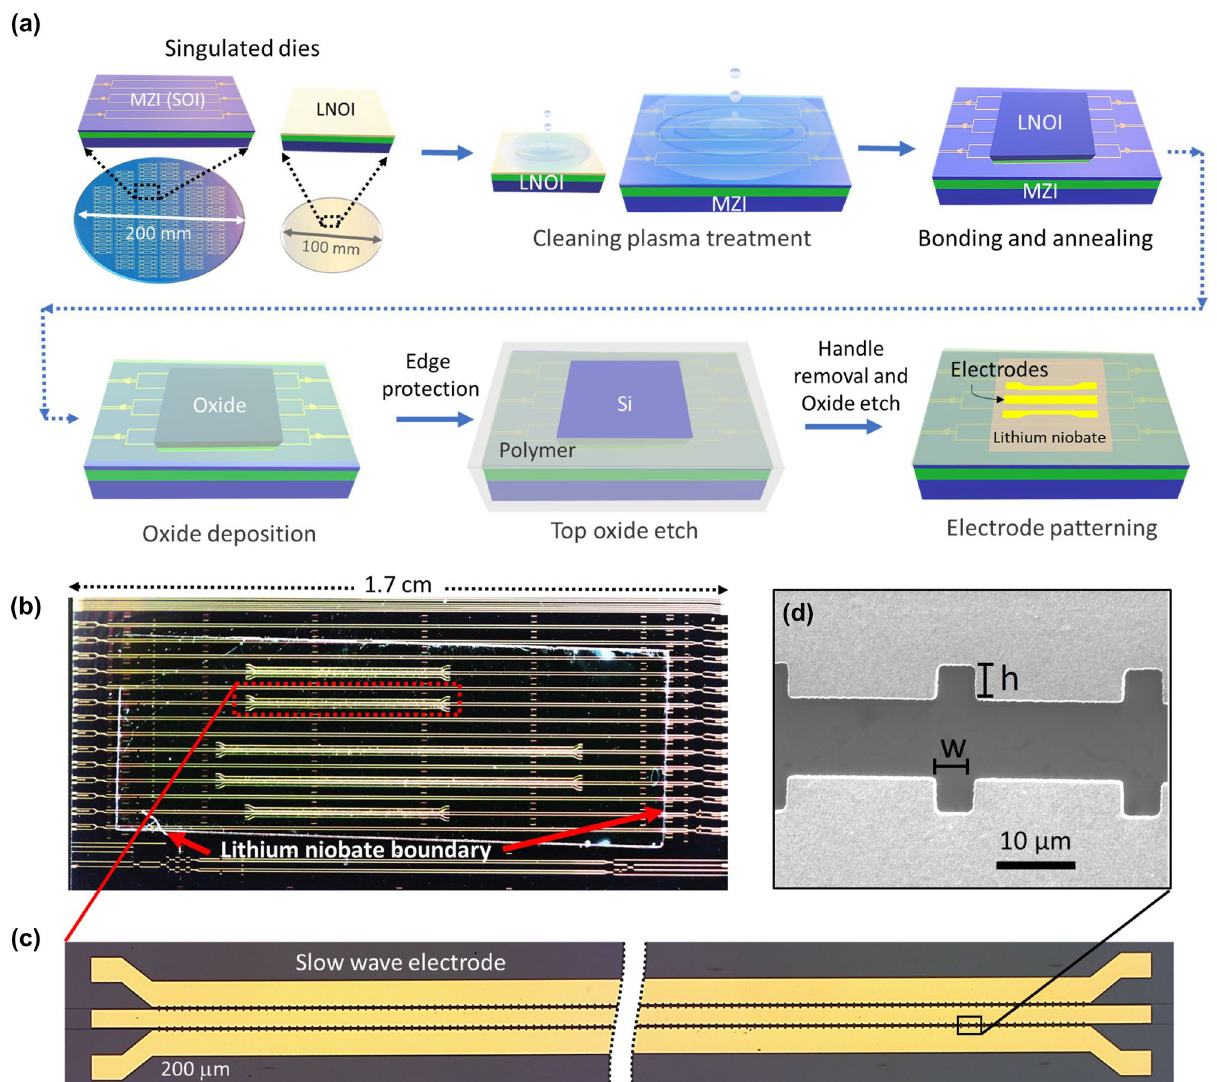
Figure 3. ( a ) Fabrication process flow of the hybrid bonded Si/LN MZM. ( b ) Optical microscope image of hybrid bonded Si/LN chip with gold SWE. ( b ) The fabricated hybrid bonded Si/LN MZM chip. ( c ) A stitched optical microscope image of a 5 mm long SWE. ( d ) A scanning electron microscope image of the inductively loaded slot